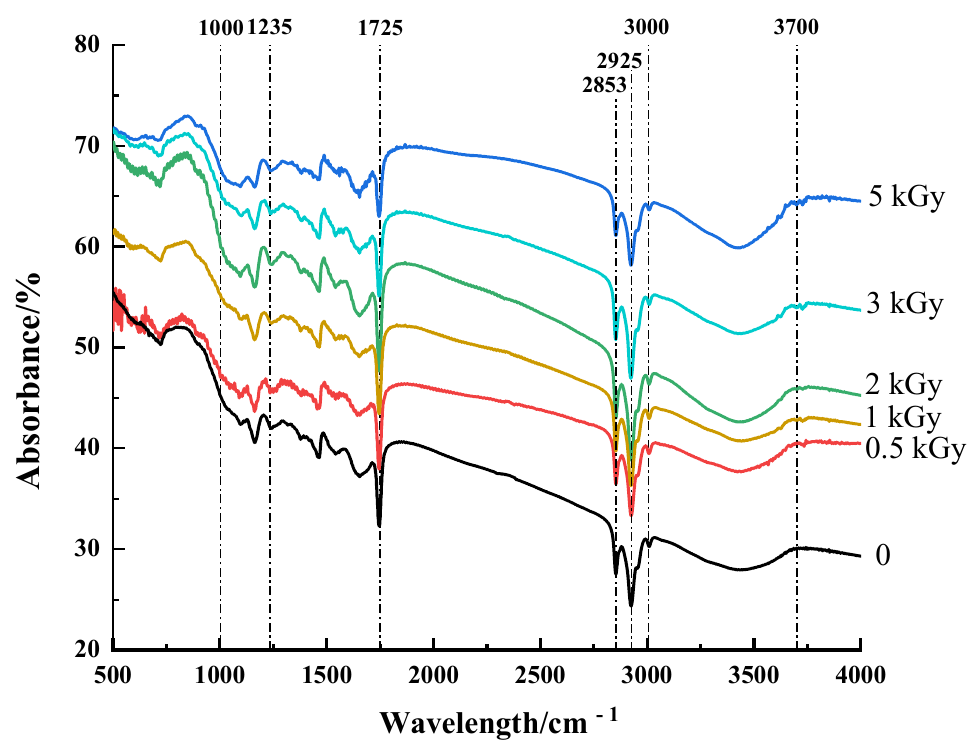
Figure 2. Effect of γ -irradiation on infrared spectrum of pea fiber.